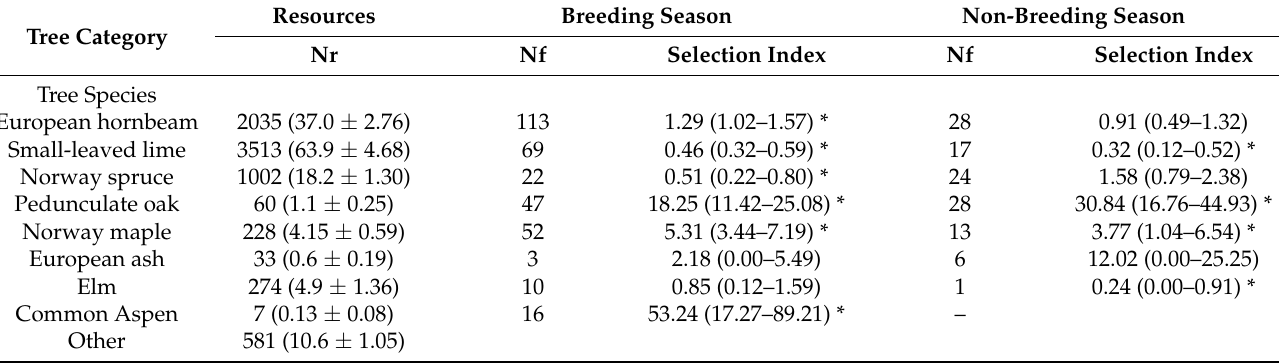
Figure 1. Percentage of Middle Spotted Woodpecker foraging time in relation to tree species in the breeding and non-breeding seasons. Table 1. Trees used by the Middle Spotted Woodpecker during foraging according to species, condition and size in relation to available resources. The “other category” includes: common hazel ( Corylus avellane L.), rowan ( Sorbus aucuparia L.), birch ( Betula spp.). Nr, the number of trees in resources measured on 55 sample plots, (mean and standard error are presented in brackets); Nf, the number of visited trees during foraging. Selection indices are presented with 95% confidence limits (in brackets). Asterisks show statistically significant results.